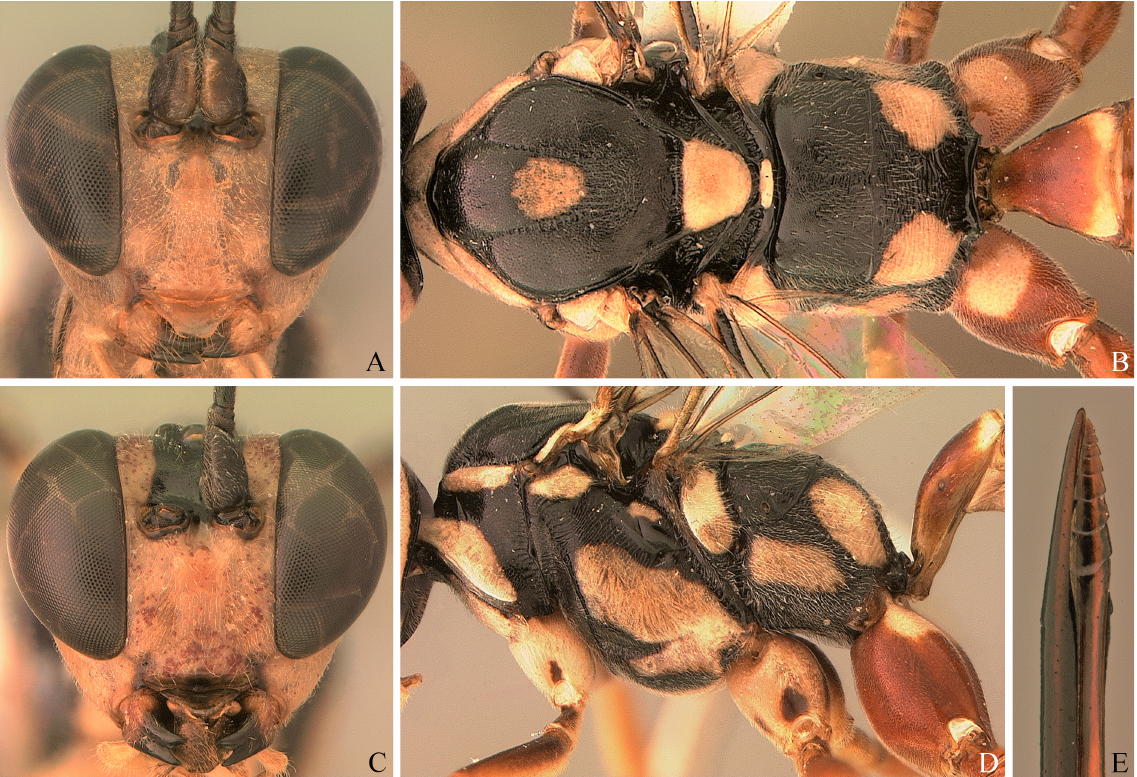
Fig. 13. Distictus paratibialis sp. nov. A . Head, frontal view; paratype (IBRP). B . Mesosoma + first tergite, dorsal view; holotype (LAPIS5907). C . Head, frontal view; holotype (LAPIS5907). D . Mesosoma, left side; holotype (LAPIS5907). E . Apex of ovipositor, left side, holotype